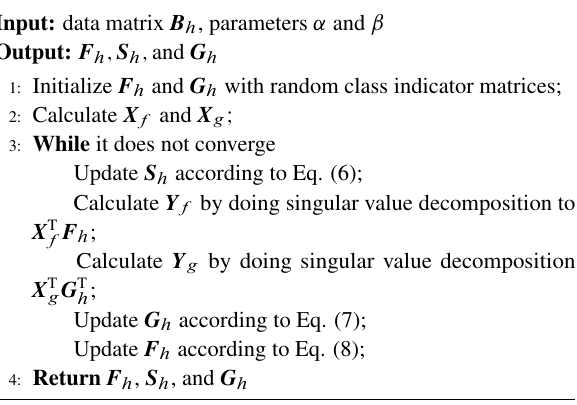
Algorithm 1 MNFRU